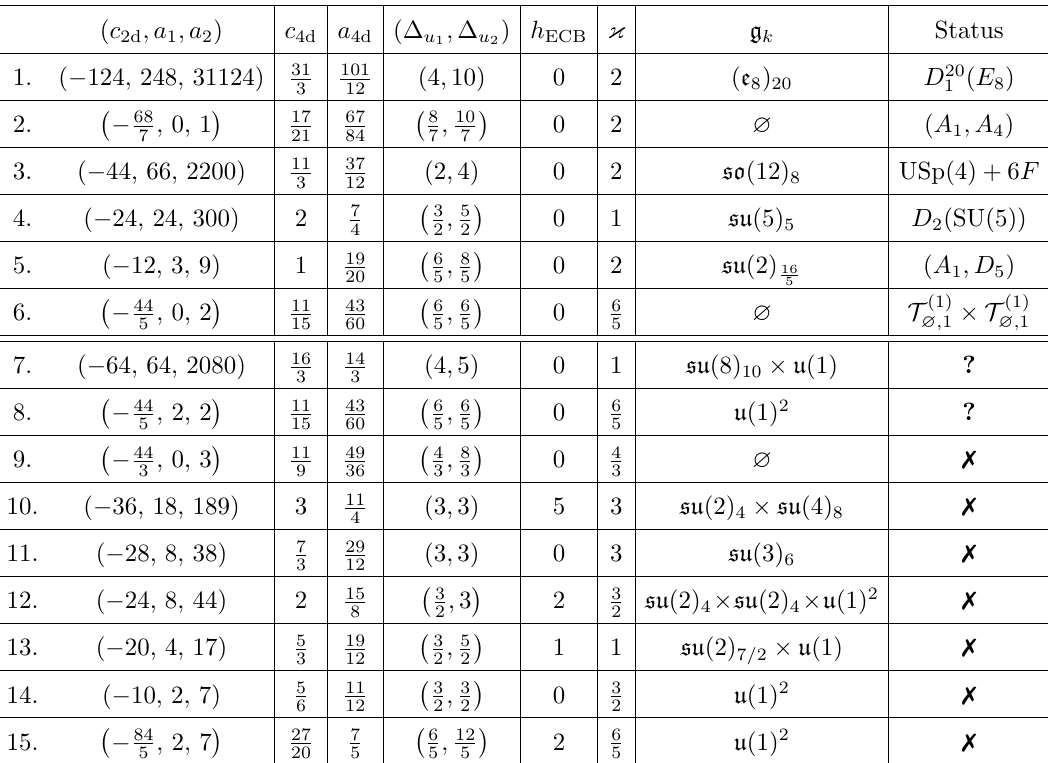
Table 3 . The 15 tentative theories identified in our scan. The first six are already known, cf. table 1 of [35]. The remaining nine theories are discussed in the rest of this work. Those marked with an 7 will be shown not to exist, while those marked with a ? have not yet been ruled out but seem unlikely to